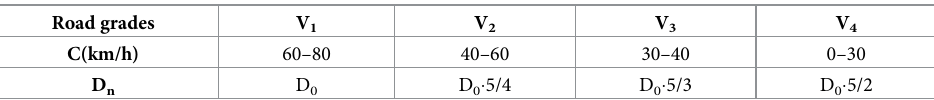
Table 2. Data of update